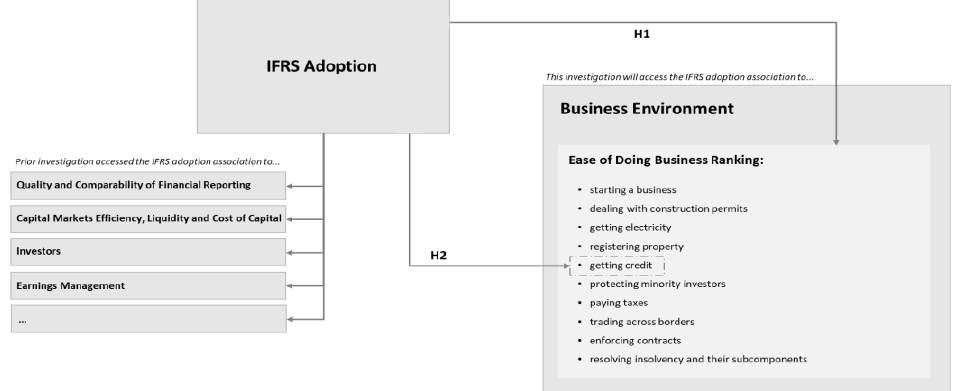
Figure 1. Conceptual framework. Source: The authors.